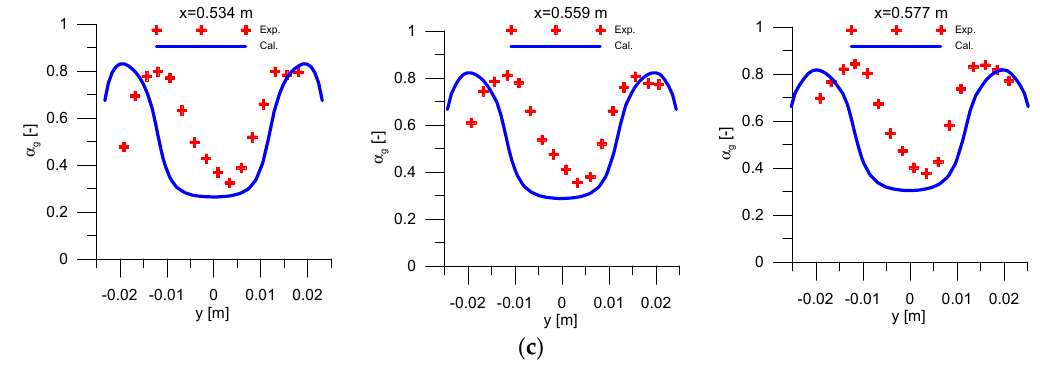
Figure 9. Comparison between calculation and experiment: ( a ) axial profile of the pressure and void fraction; ( b ) radial profile of the void fraction; ( c ) radial profile of the void fraction at different axial positions.